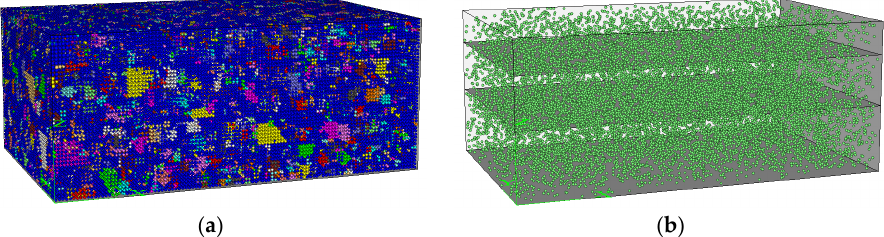
Figure 3. Discrete element model of asphalt pavement. ( a ) Discrete element model. ( b ) Voids distribution in the model.